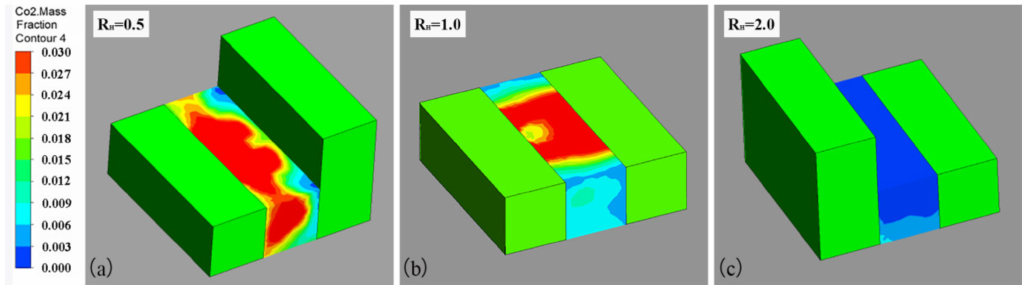
Figure 17. Contours of street ventilation surfaces with different height ratios: ( a ) R H = 0.5; ( b ) R H = 1.0; ( c ) R H = 2.0.